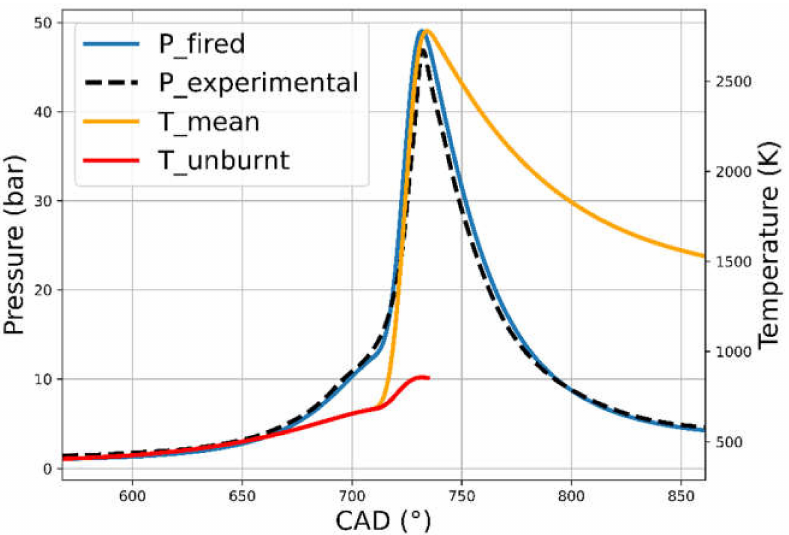
Figure 1. Comparison between modeled ( blue ) and experimental ( dashed black ) pressure curves for the CFR engine. The modeled burning and the fresh mixture temperature are also